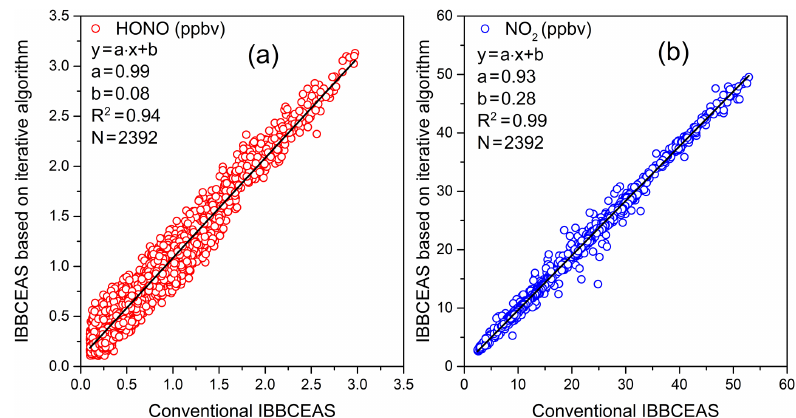
Figure 11. The correlation between the measurement results of the two IBBCEAS systems: (a) correlation between the HONO concentrations determined by two IBBCEAS systems; (b) correlation between the NO 2 concentrations determined by two IBBCEAS systems.